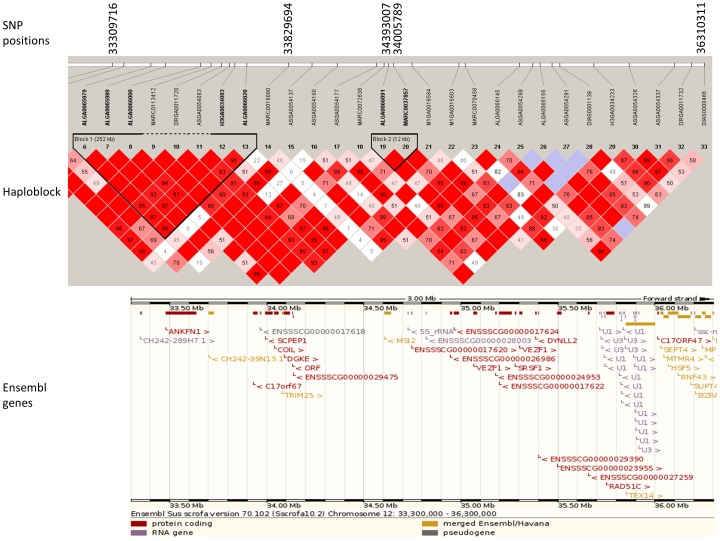
Linkage disequilibrium (LD) pattern and Ensemble genes on region from 33.5–35.5 Mb on pig chromosome 12.LD blocks are marked with triangles. Values in boxes are LD (r2) between SNP pairs and the boxes are colored according to the standard Haploview color scheme: LOD >2 and D'  = 1, red; LOD >2 and D'<1, shades of pink/red; LOD<2 and D'  = 1, blue; LOD<2 and D'<1, white (LOD is the log of the likelihood odds ratio, a measure of confidence in the value of D').